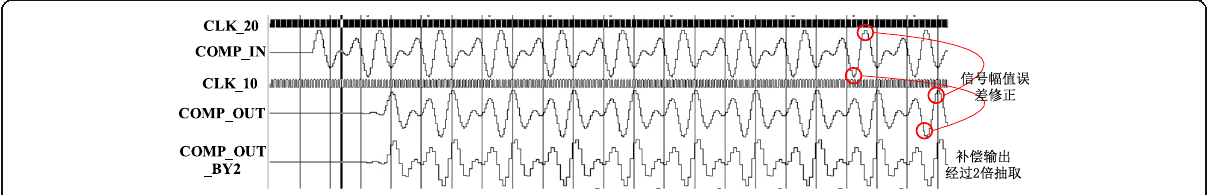
Fig. 12 Twofold decimation results after compensation filter